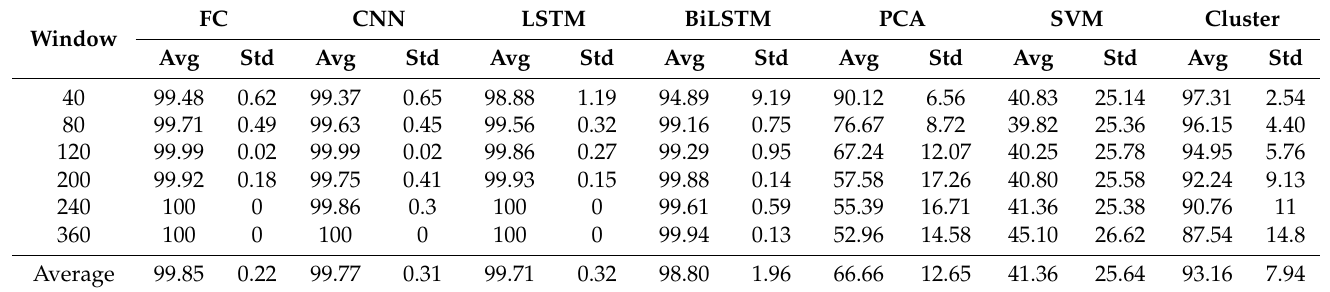
Table 8. Average F1 score and standard deviation for each window size in normal operating conditions.